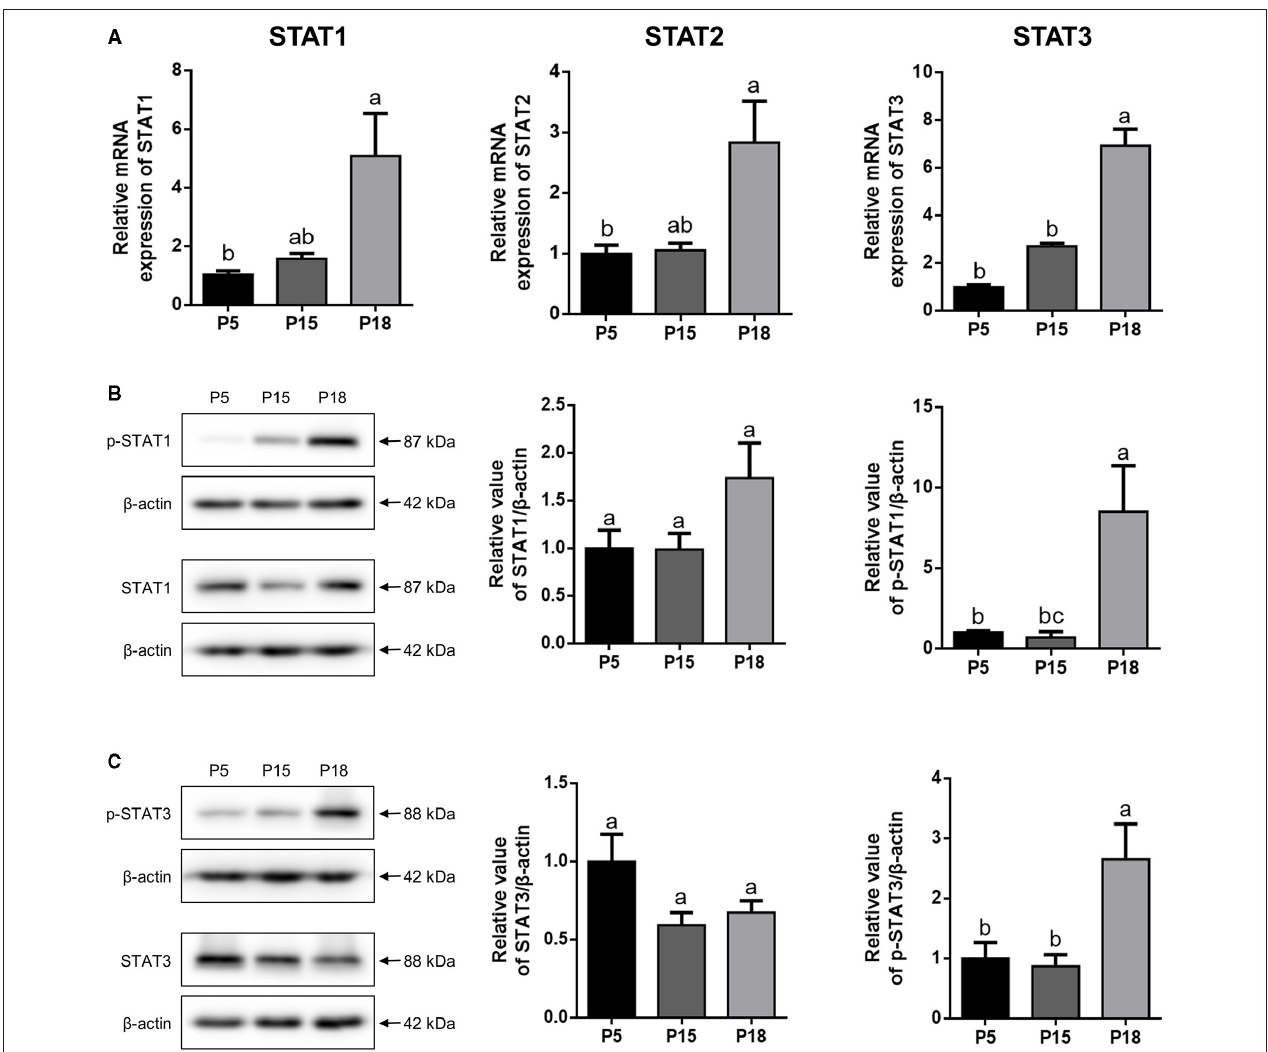
FIGURE 5 | The expression analysis of STATs in goat uterus during early pregnancy. (A) Relative mRNA level of STAT1, STAT2, and STAT3 was detected by qRT-PCR in pregnant goat uterus on post-mating days 5 (P5), 15 (P15), and 18 (P18). Gene expression was normalized to GAPDH. (B,C) The protein expression of p-STAT1, STAT1, p-STAT3, and STAT3 in goat uterus was analyzed by Western Blotting. All the data are presented as the mean ± S.E.M. from three independent experiments, and bars with different letters (a/b/c) are significantly different ( p <